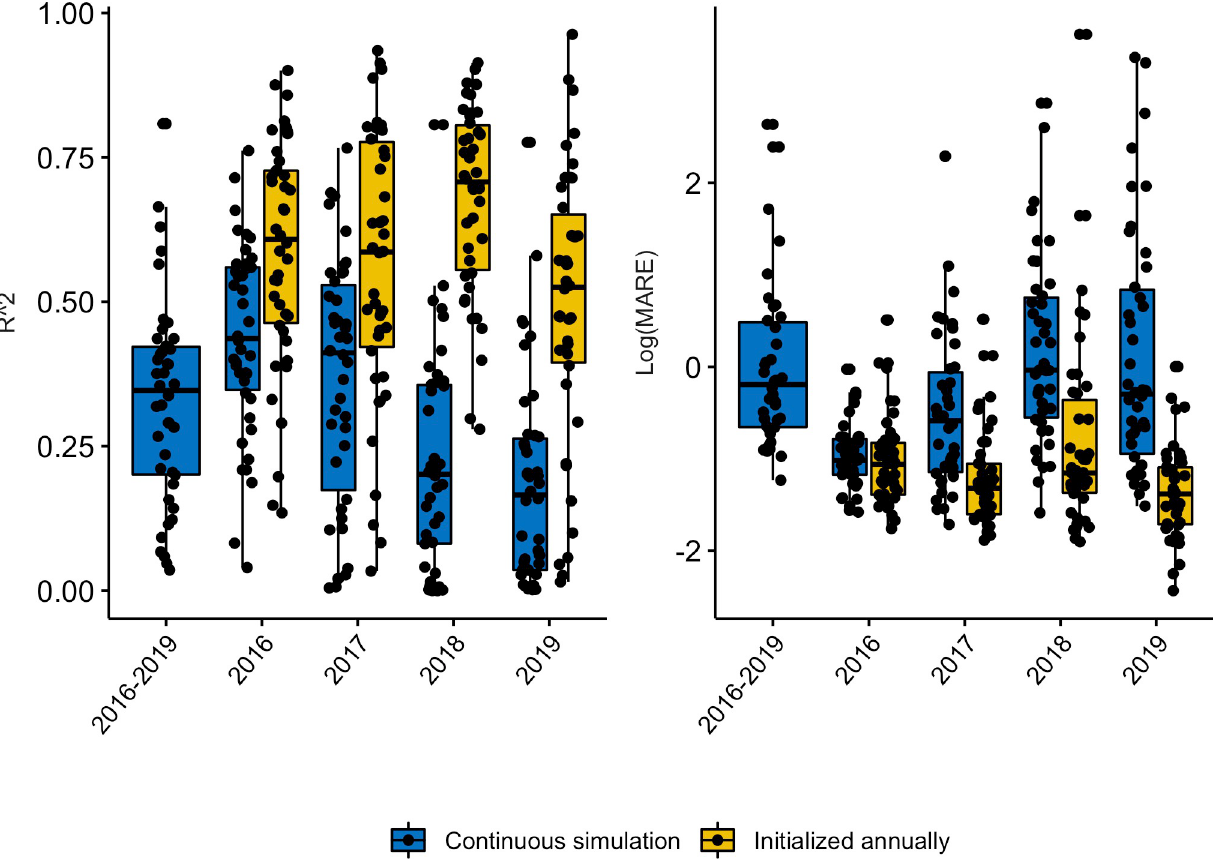
Fig 2. Fit of predicted malaria incidence, across all 42 catchment sites, computed over various study periods. Outcomes computed from continuous weekly simulation of incidence are indicated by the blue boxes. Outcomes computed from yearly reinitialization are indicated by the yellow boxes. Left panel: the coefficient of determination (R 2 ). Right panel: log-scaled Mean Absolute Relative Error (MARE) across different sites (jittered black dots).